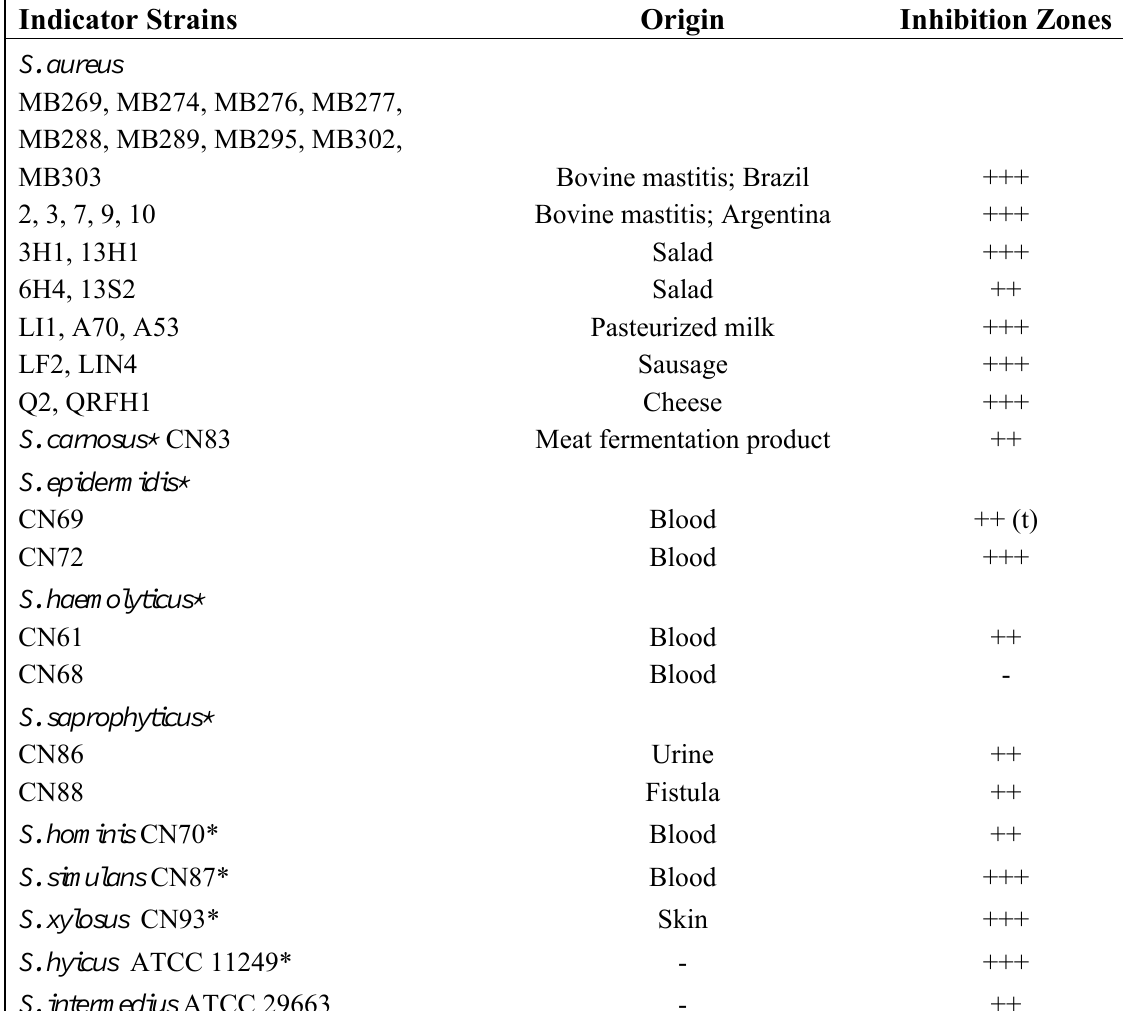
Table 2. Antimicrobial spectrum of lysostaphin against Staphylococcus spp.